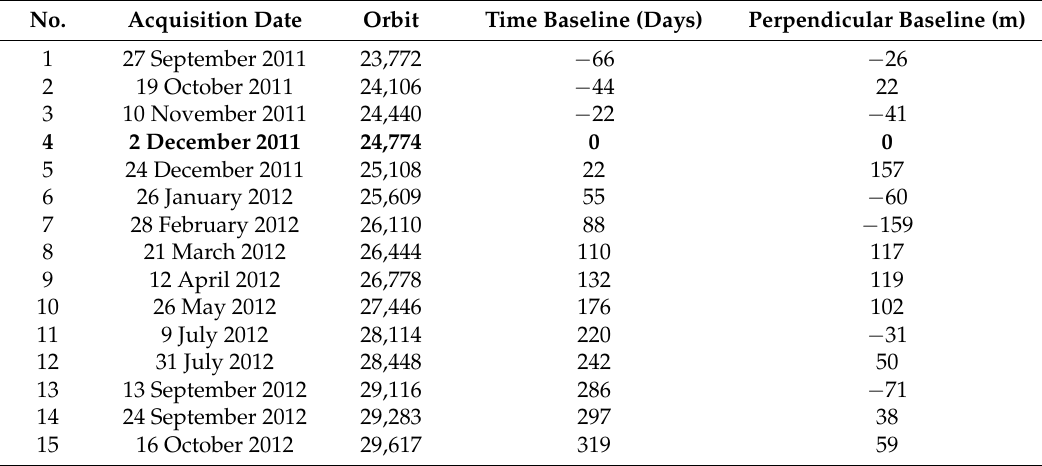
Table 1. Basic parameters of TerraSAR